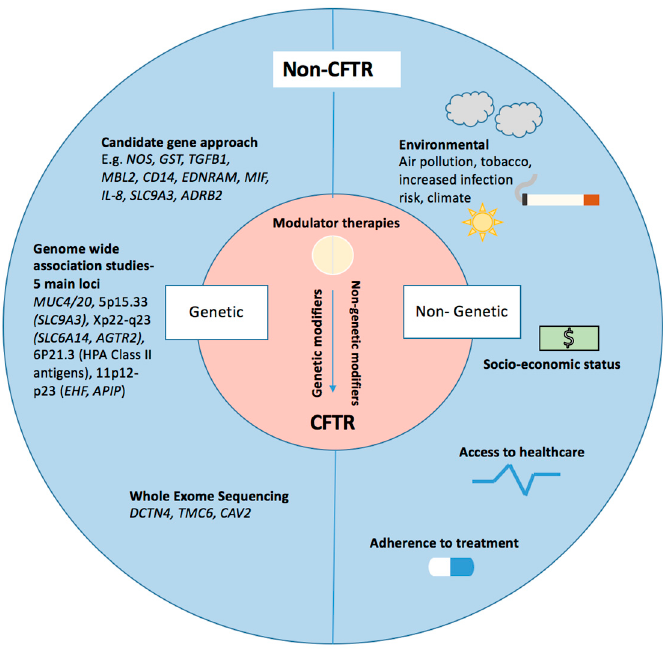
Figure 1. Modifiers of cystic fibrosis (CF) respiratory pathophysiology—key genetic and non-genetic modifiers are illustrated. Genetic modifiers listed have been identified through various techniques including a candidate gene approach, genome-wide approaches and whole exome sequencing. Non-genetic modifiers have been highlighted.